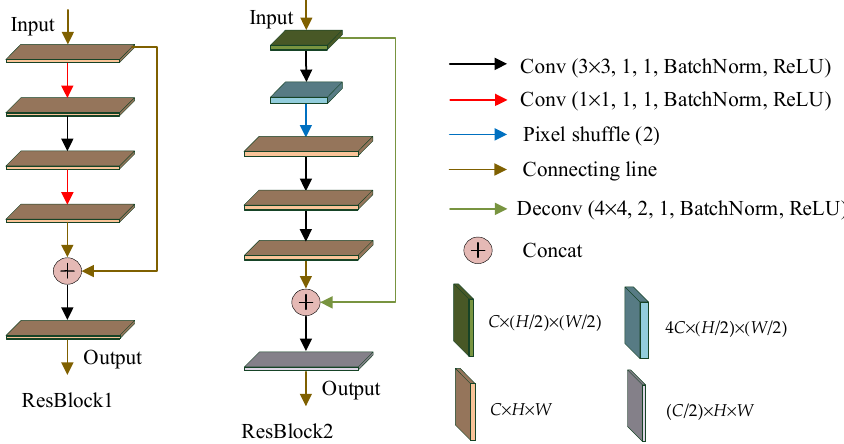
Figure 1. Two ResBlocks (Conv: Convolutional network, Concat: Concatenation operation, Deconv: Deconvolutional network).